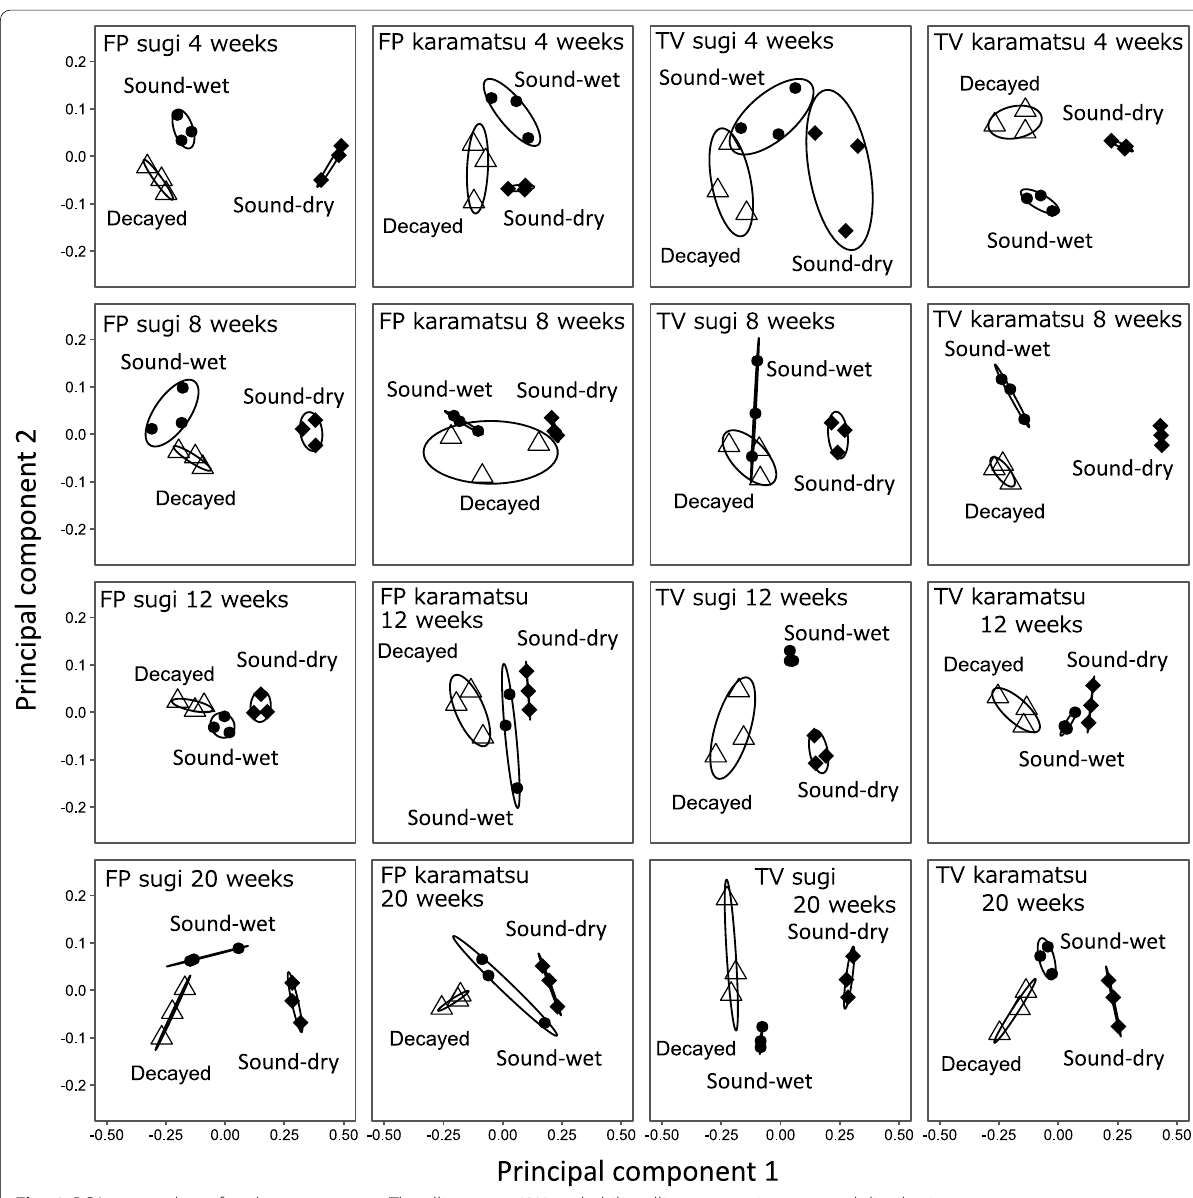
Fig. 6 PCA scatterplots of each measurement. The ellipses are 68% probability ellipses assuming a normal